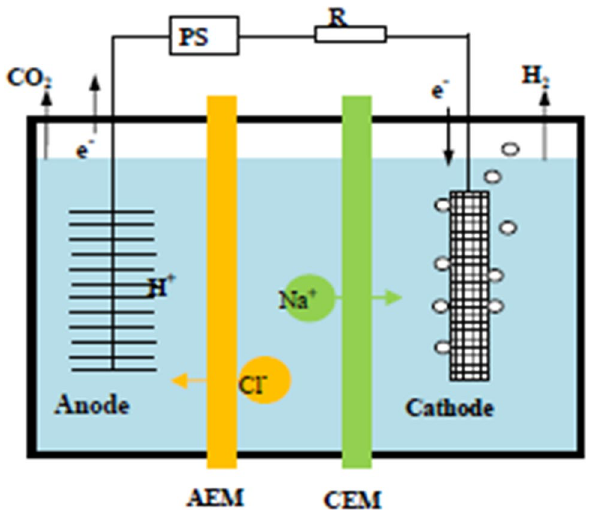
Fig. 1 Microbial desalination cell (Luo et al. 2010)